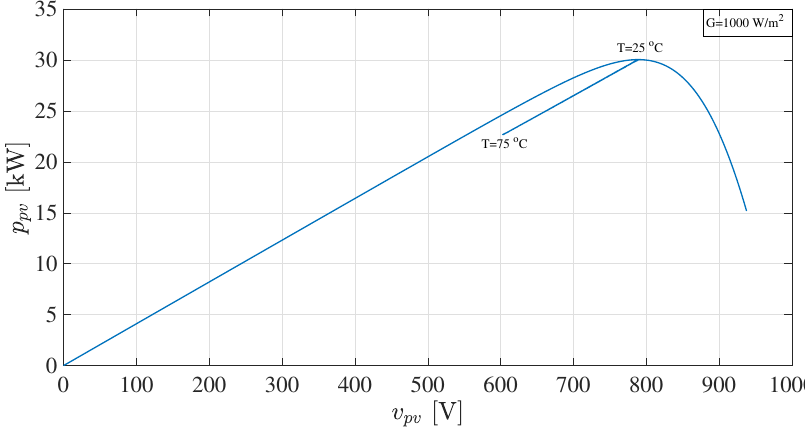
Figure 21. Power–voltage portrait during constant radiation and gradual change of temperature.